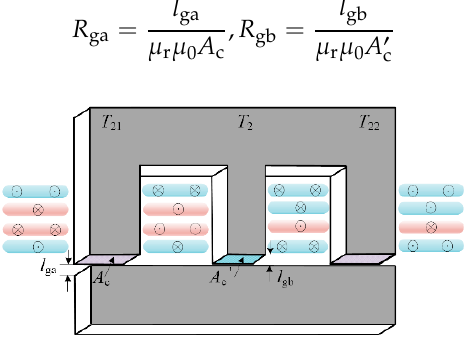
Figure 5. Improved EI core structure of T 2 .